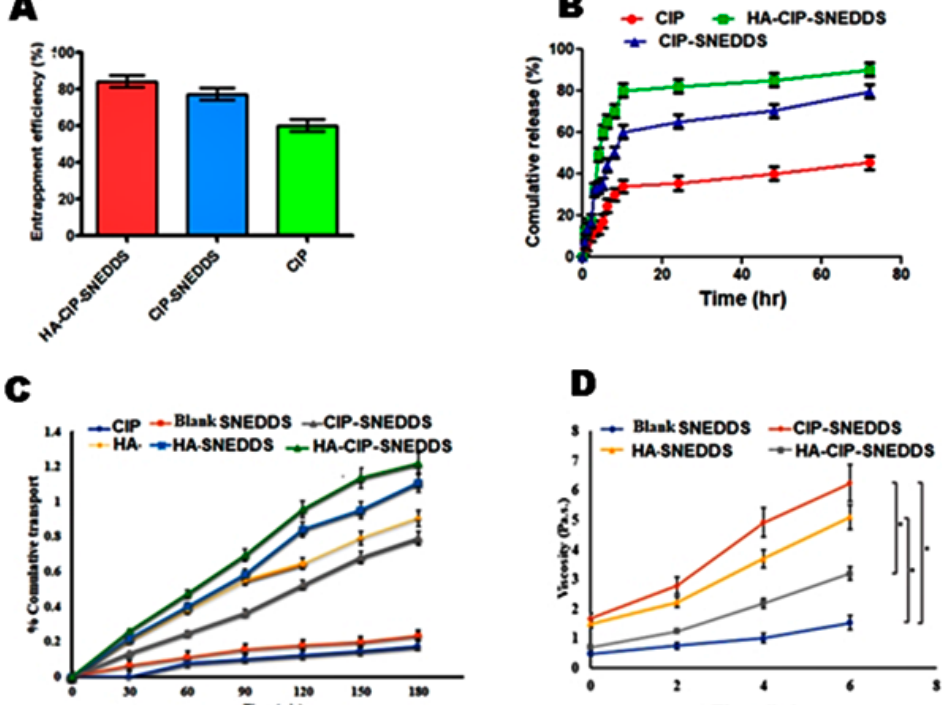
Figure 5. Drug entrapment efficiency of HA functionalized CIP SNEDDS. ( A ) Dissolution studies from CIP and other formulations ( B ). Permeation of CIP and SNEDDS; ( C ) Rheological studies of SNEDDS to determine mucoadhesion and ( D ). Results are listed as duplicates mean ± S.D ( p < 0.05), and statistically significant differences were evaluated by one- way ANOVA with a significance level of p <